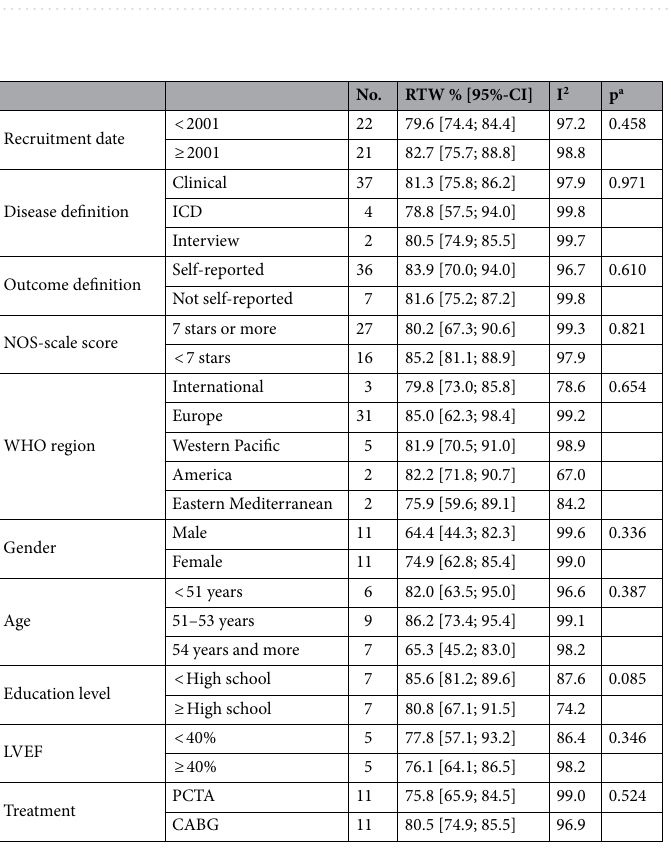
Table 1. Return to work overall random effects pooled prevalence, according to the characteristics of the studies and the clinical and socio-professional characteristics of the patients. CABG, coronary artery bypass graft surgery; CI, confidence interval; ICD, International Classification of Diseases; LVEF, Left Ventricular Ejection Fraction;N°, number of studies; NOS, Newcastle–Ottawa scale; P, p-value; PCTA, percutaneous coronary transluminal angioplasty; RTW %, return to work overall random effects pooled prevalence. a Between group